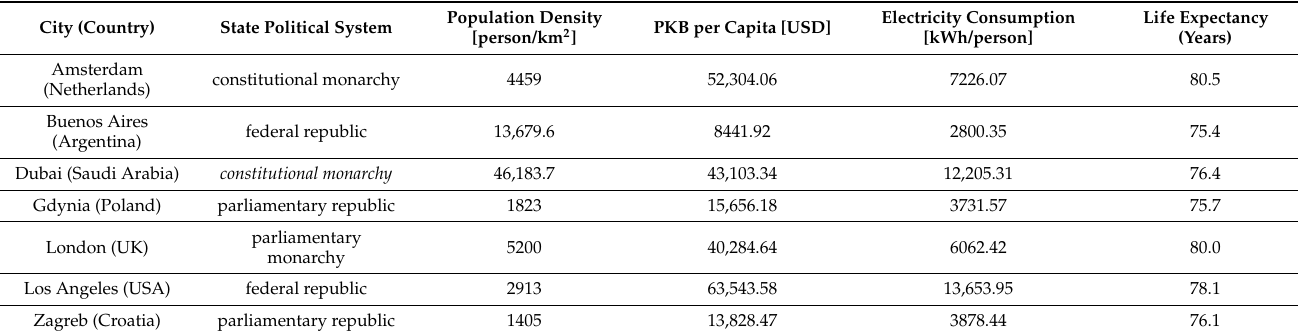
Table 1. Selected data regarding analysed